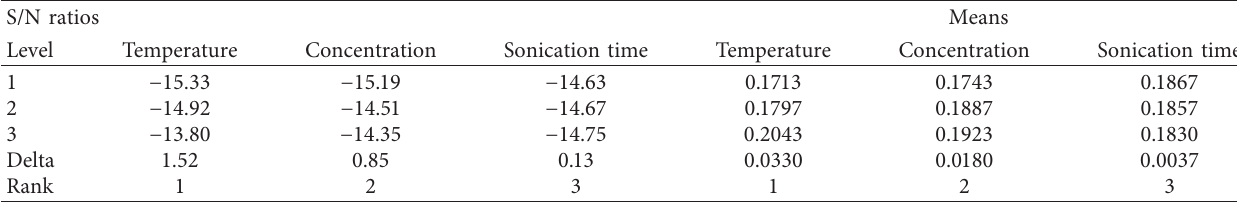
Table 5: S/N ratio and means for thermal conductivity (ball-milled process).